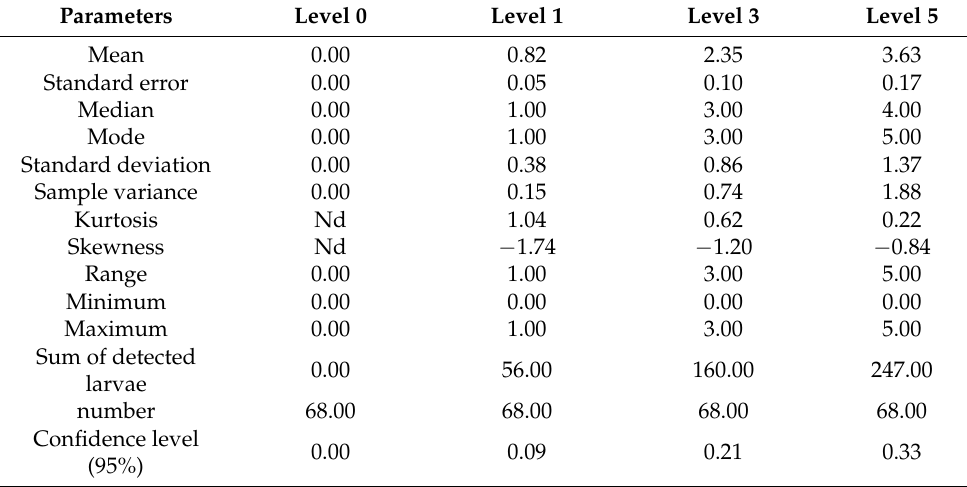
Table 4. Descriptive statistics of reported results.